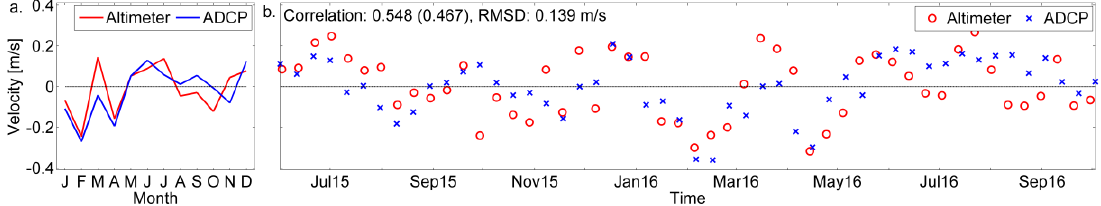
Figure 5. ( a ) Altimeter-derived and ADCP-measured monthly mean along-shelf velocity anomalies; ( b ) altimeter-derived and ADCP-measured full along-shelf velocity anomalies time series. The correlation coefficient and RMSD are shown in the upper left corner of the panel. Water 2018 , 10 , x FOR PEER REVIEW